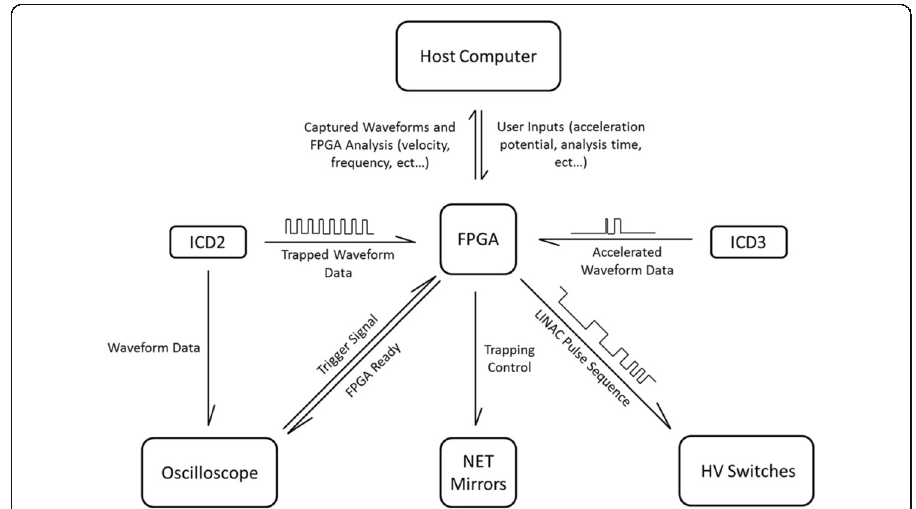
Fig. 5 Schematic of the Aerosol Impact Spectrometer data acquisition and computer control